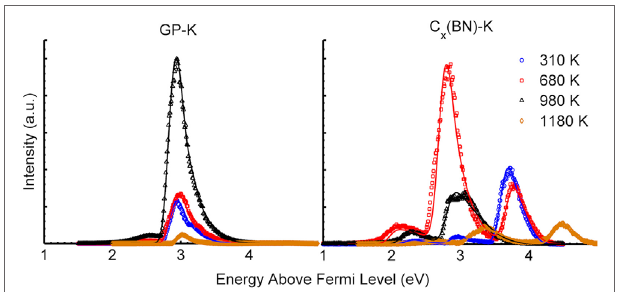
FigUre 8 | Photoemission electron energy distributions recorded at 310, 680, 980, and 1,180 K during the fourth heating cycle of AM1.5 solar simulator illuminated GP-K petals and C x (BN)-K petals. Corresponding fits from theory are also